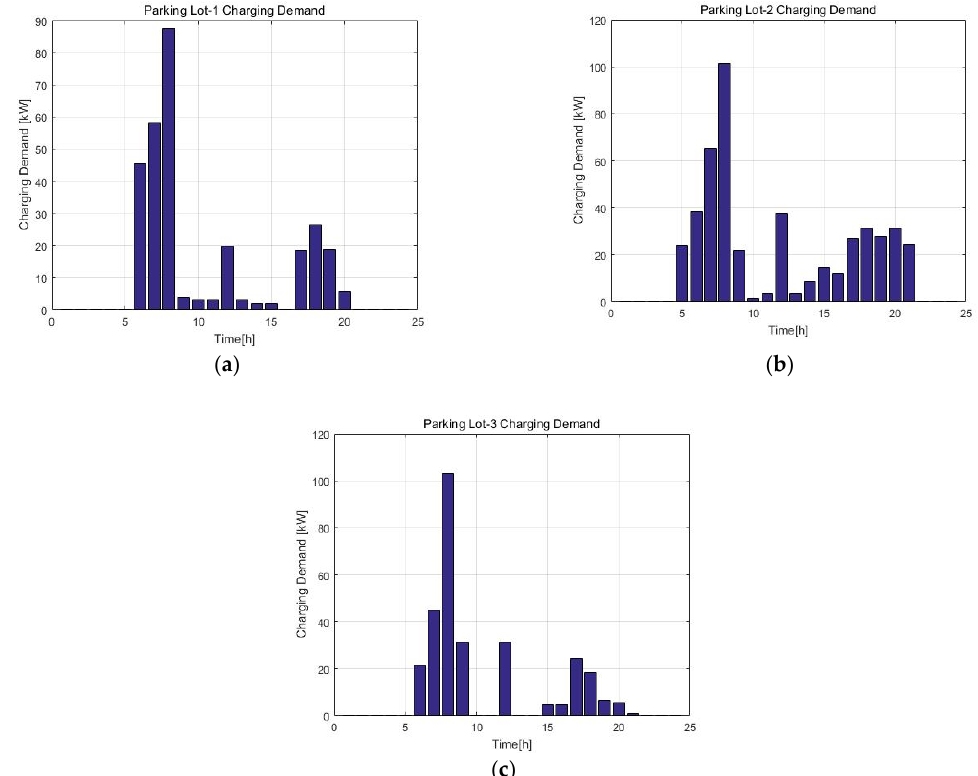
Figure 11. Total Charging Load of Parking Lot ( a ) PL1, ( b ) PL2, (c ) PL3.